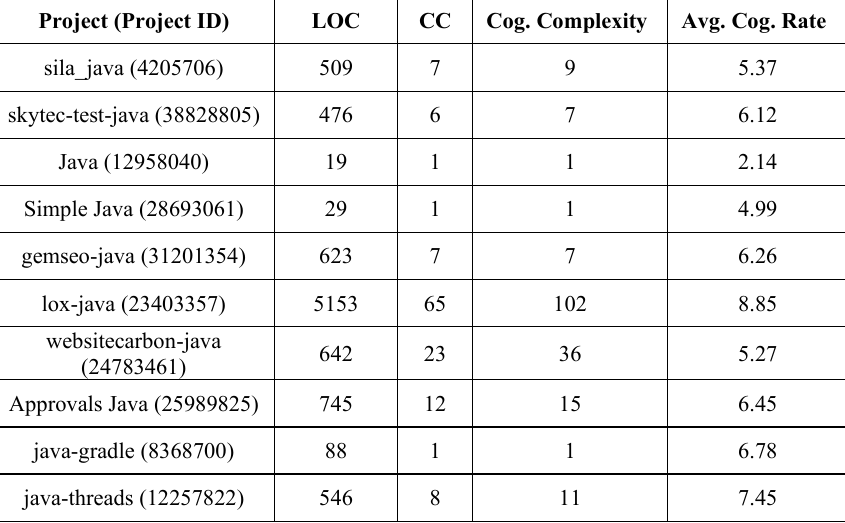
Table 4. Cognitive ratings for sample Java